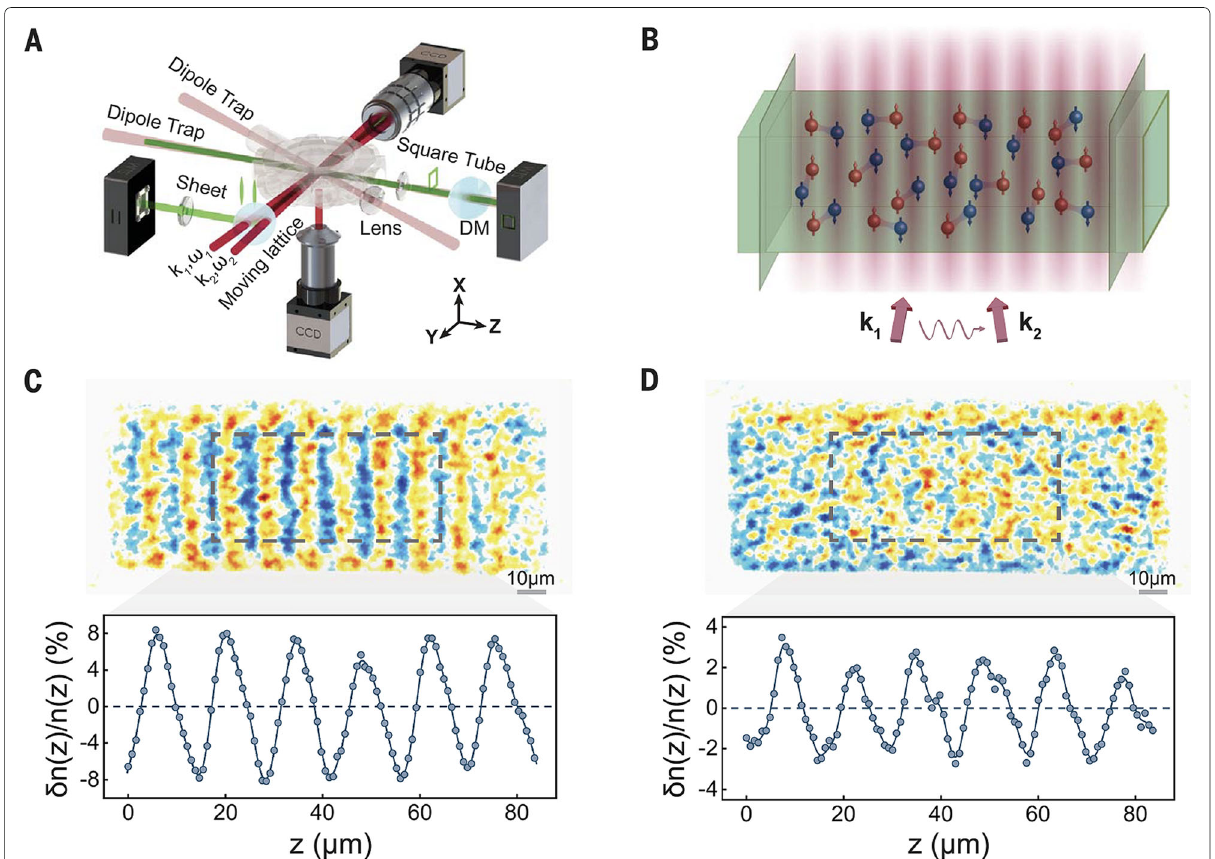
Fig. 13 a The experimental setup: a box trap consists of a square tube and two sheets of laser beams. b A pair of 741-nm laser beams with wave numbers ( k 1 = k 2 = k L ) and frequencies ( ω 1 , ω 2 ) intersect on the homogeneous unitary Fermi gas with a small angle, producing a one-dimensional moving-lattice potential. c , d First and second sound waves. The upper panels show two typical single-shot images of unitary superfluid at T = 0.84 T c , taken at the frequencies ω = ω 1 − ω 2 = 2.1 kHz and 0.3 kHz, respectively. To clearly show the density waves along the longitudinal z -axis, we have taken the difference with respect to a reference image at ω = 1 MHz. Further integration of the difference along the two transverse directions in the region of interest, as marked by the dashed box, reveals a normalized density fluctuation δ n / n propagating along the z -axis, as shown in the low panels. From Ref.